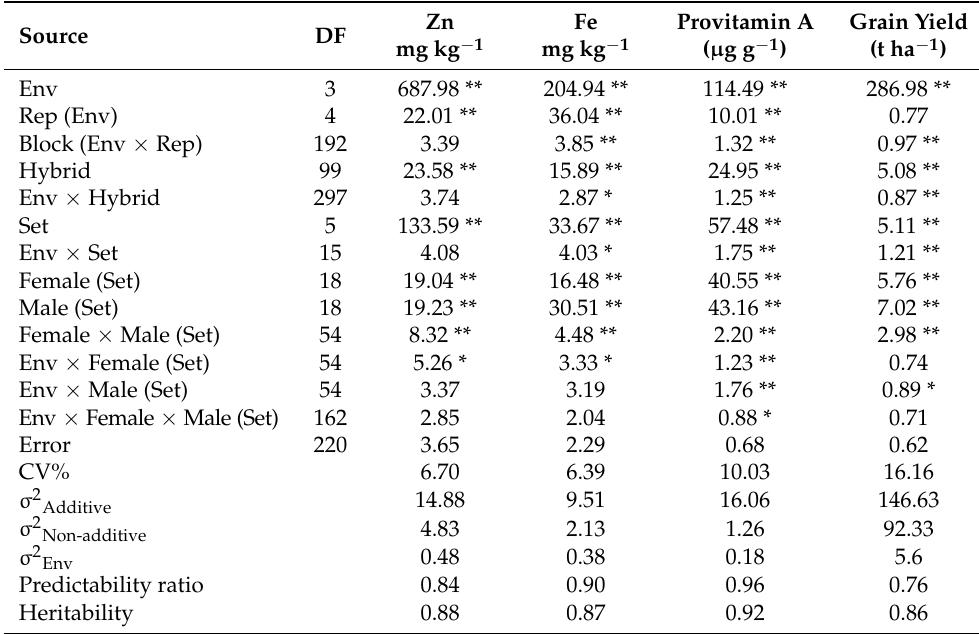
Table 2. Mean squares from the combined analysis of variance across environments for micronutrients and grain yield of 96 maize hybrids and four commercial